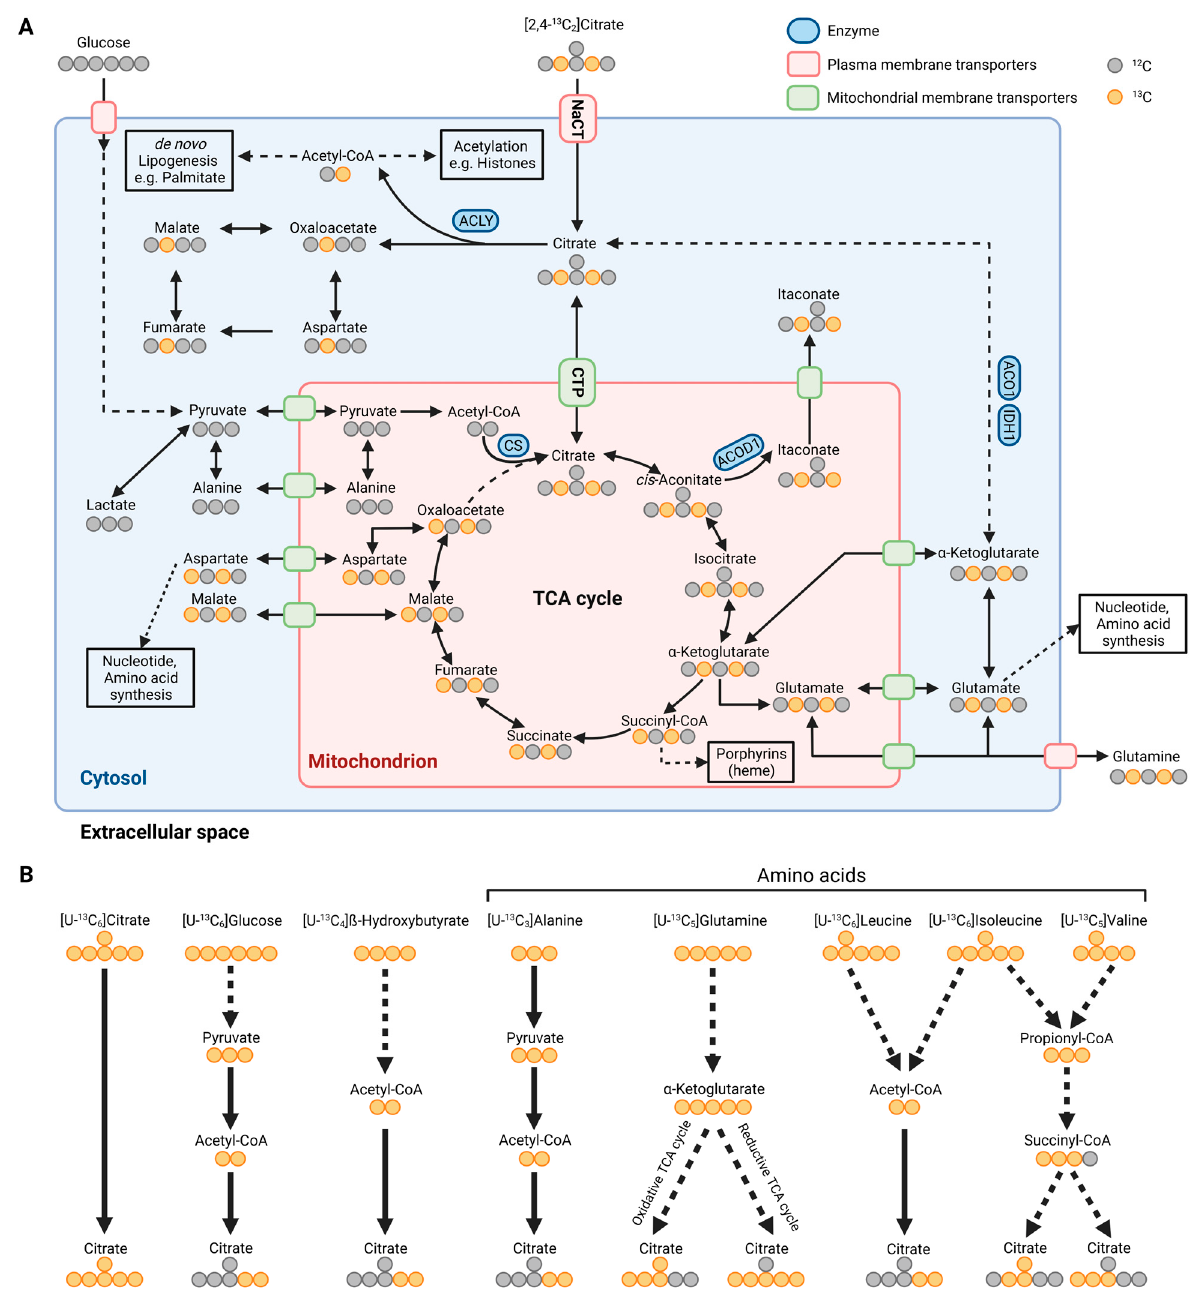
Figure 2. Metabolic map depicting carbon atom transitions and substrates fueling citrate metabolism. ( A ) Schematic of extracellular [2,4- 13 C 2 ]citrate depicting carbon incorporation into tricarboxylic acid (TCA) cycle, lipogenesis, and amino acid synthesis in the cytosol and mitochondria. ( B ) Schematic depicting substrate utilization for citrate metabolism using [U- 13 C 6 ]citrate, [U- 13 C 6 ]glucose, [U- 13 C 4 ] β -hydroxybutyrate, [U- 13 C 3 ]alanine, [U- 13 C 5 ]glutamine, [U- 13 C 6 ]leucine, [U- 13 C 6 ]isoleucine, and [U- 13 C 5 ]valine. Labeled carbons are depicted in orange and unlabeled ones are depicted in grey. ACLY: ATP-citrate lyase; CS: citrate synthase; ACOD1: cis -aconitate decarboxylase; ACO1: aconitase 1; IDH1: isocitrate dehydrogenase 1; NaCT: sodium-coupled citrate transporter; CTP: mitochondrial citrate transport protein. (Created with